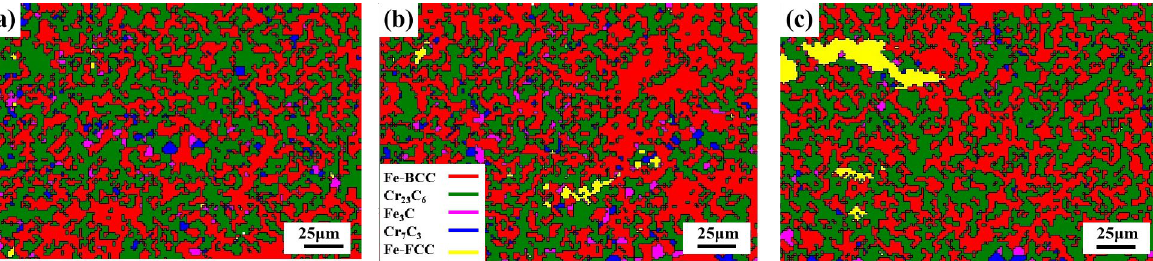
Figure 7. Phase distribution of different coatings from EBSD: ( a ) Fe-based coating, ( b ) 6% γ -Fe coating, ( c ) 9% γ -Fe coating.